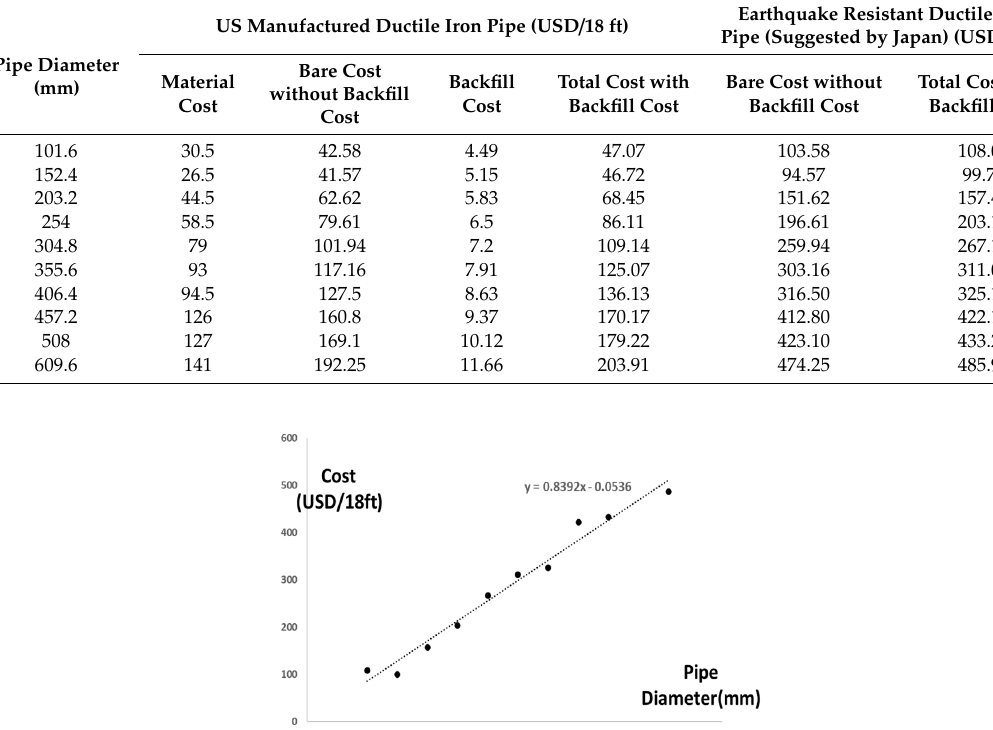
Table 1. Cost of Replacement of Seismic Performance Pipes (Shahandashti and Pudasaini, 2019).